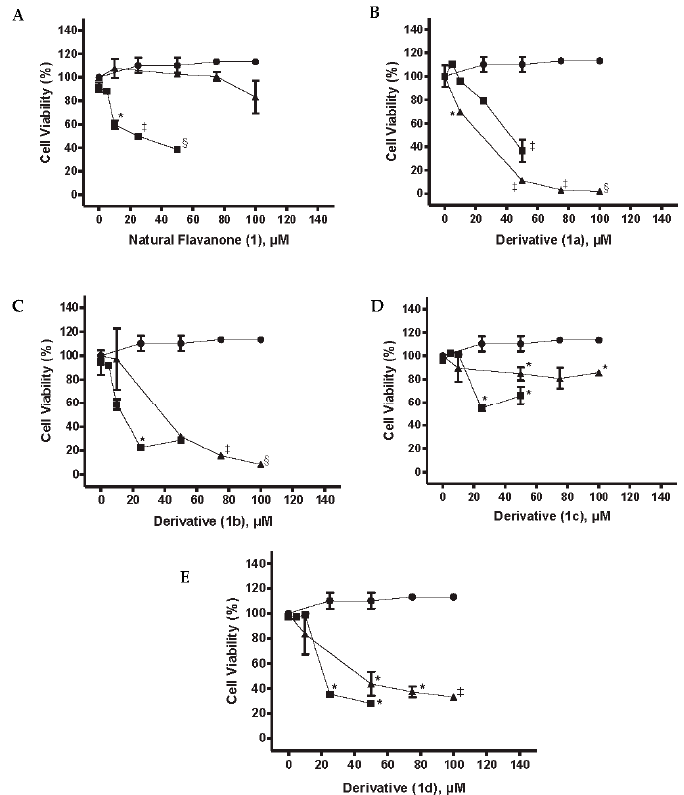
Figure 4. Dose dependent cytotoxicity against MiaPaCa-2 cell line of blank NPs ( ● ), natural flavanone or derivative ( ■ ), and natural flavanone or derivative loaded in NPs ( ▲ ); natural flavanone ( 1 ) ( A ), derivative ( 1a ) ( B ); derivative ( 1b ) ( C ); derivative ( 1c ) ( D ); derivative ( 1d ) ( E ). Each point represents the mean ± SD ( n = 3). (*) Denotes statistically significant differences regarding blank NPs, p < 0.05, (‡) denotes statistically significant differences regarding blank NPs, p < 0.001, and (§) denotes statistically significant differences regarding blank NPs, p < 0.0001.